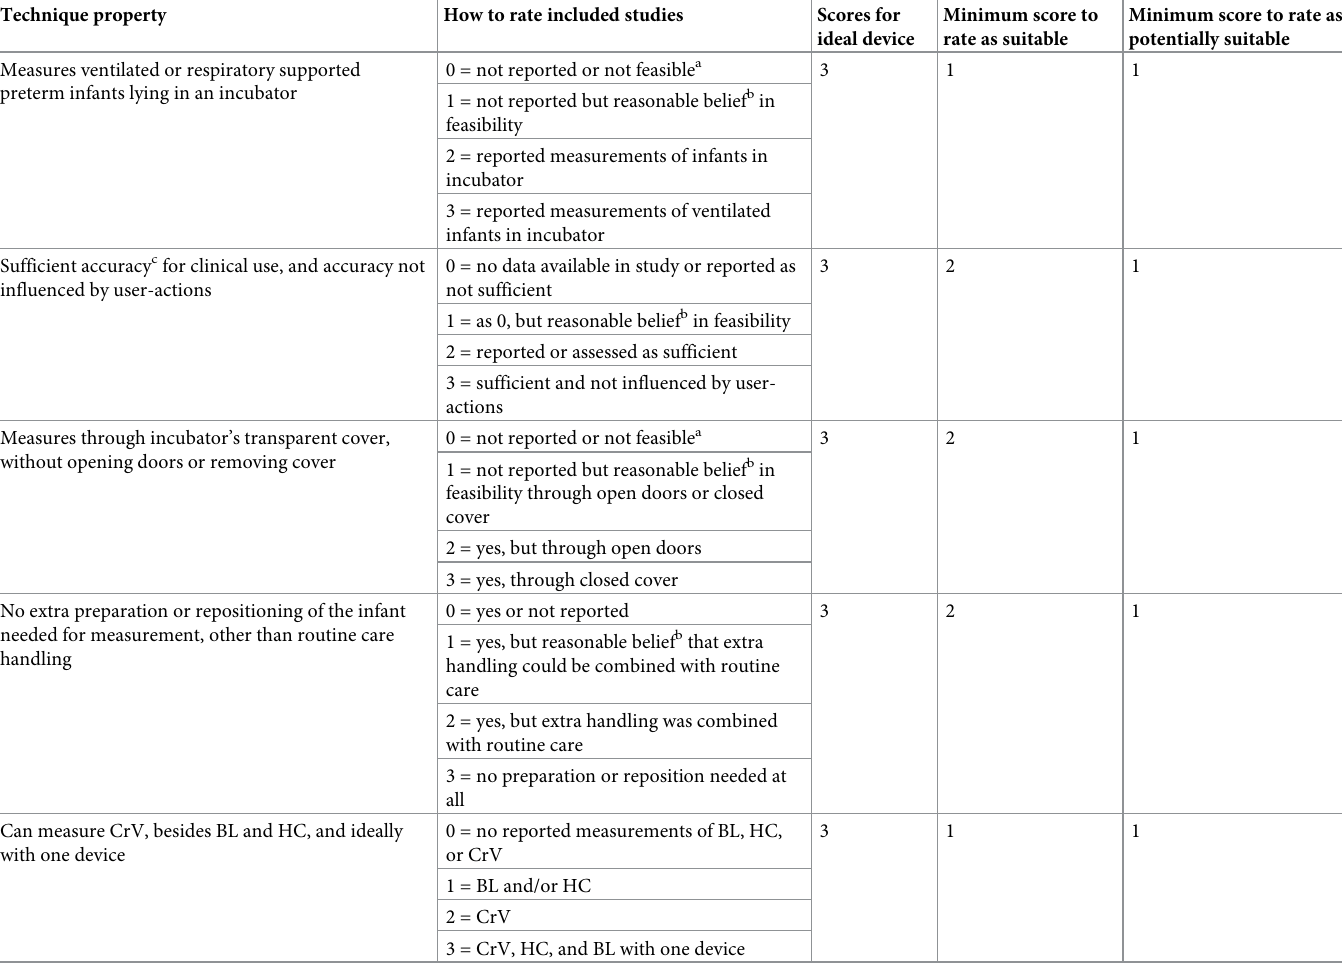
Table 1. Properties to assess the techniques’ suitability for measuring the body size of a preterm infant lying in an incubator. Technique property How to rate included studies Scores for